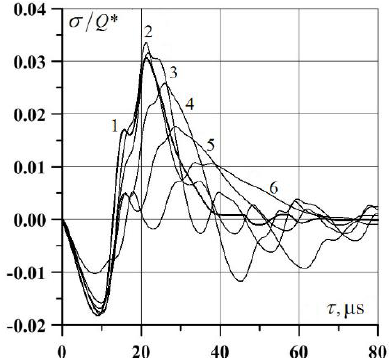
Fig. 3. Change of radial stresses depending on the time elapsed from the moment of arrival of the blast wave to a point at a distance of 20 r for different values of the air gap ∆ s : 1 - 0 (without a gap), 2 – 0.25 cm, 3 – 0.5 cm, 4 – 1 cm, 5 – 1.75 cm, 6 – 3 cm